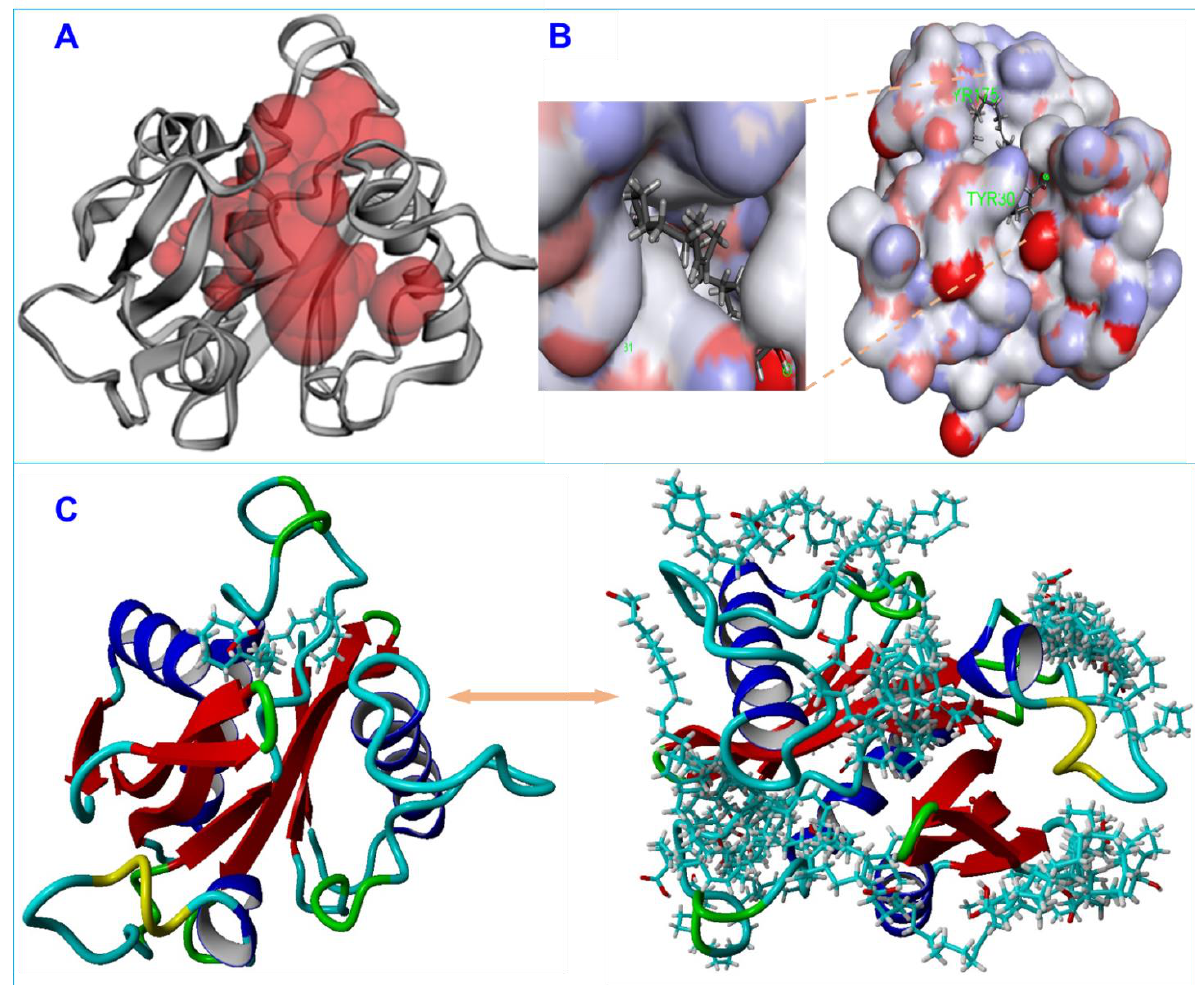
Figure 3. The putative predicted active pocket of ligand binding on the rigid surface of AbaI is shown in red ( A ), stable conformation of the ligand–receptor complex ( B ), and 25 molecular docking runs of nervonic acid with AbaI receptor ( C ).